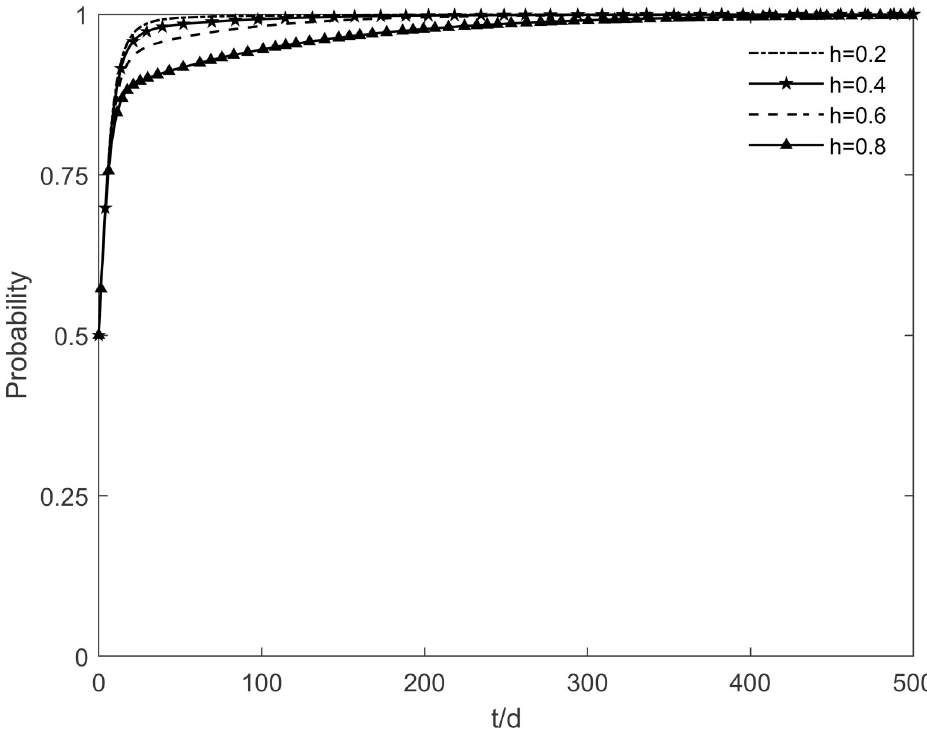
Fig 3. The impact of h on the government’s strategic choices.